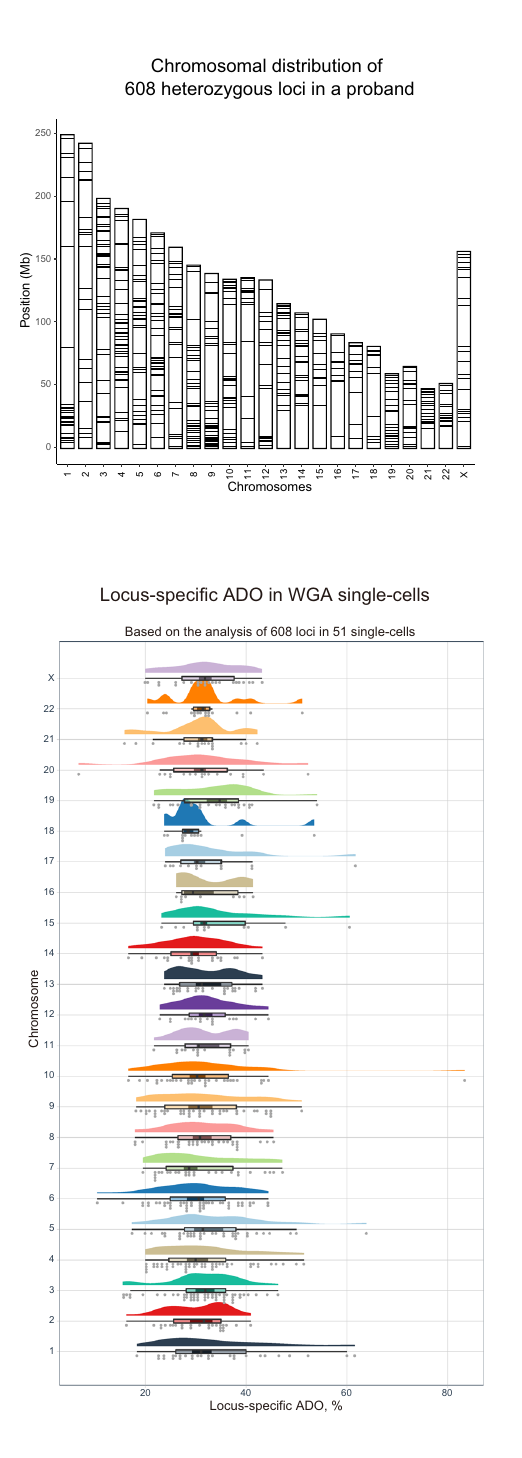
( n =3); n represents biologicallyindependent number of samples. d Chromosome- and locus-speci fi c ADO rates for each of 608 targeted heterozygous loci. Based on the data from n =51 single-cells examined over four independent experiments. e Frequency of ADO in three genomic regions closest to CRISPR/Cas9-targeted MYBPC3 , MYH7, and LDLRAP1 loci. Based on the data from 51single-cellsexamined overfourindependentexperiments.Foreachboxplotin( b – e ):centerline,median; boxbounds, 25th and 75th percentiles; whiskers, minimum to maximum within 1.5 interquartile range; data points outside whiskers, outliers. Source Data are pro- vided as Supplementary Data 5 and